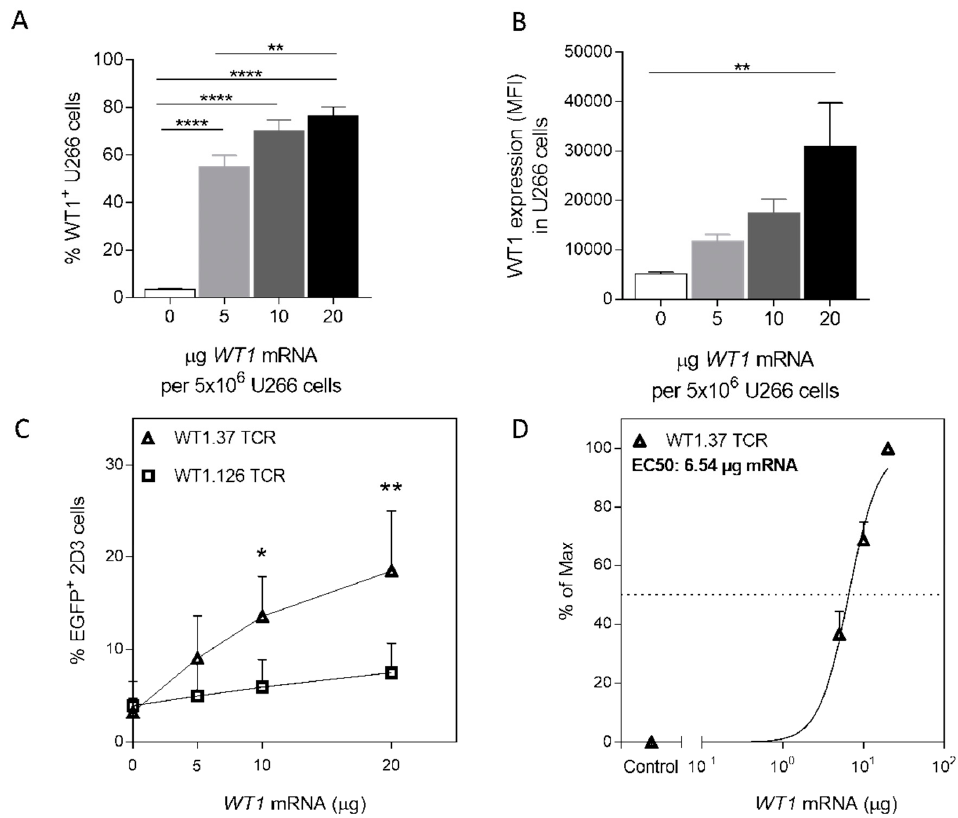
Figure 3. Epitope-specific TCR-engineered 2D3 cells can recognize full-length antigen WT1 mRNA- electroporated U266 cells in a dose-dependent manner. ( A , B ) Intracellular expression of WT1 is shown for U266 cells 24 h after electroporation with increasing amounts of WT1 mRNA per 5 × 10 6 U266 cells. ( C , D ) 2D3 cells were electroporated with WT1 37–45 - or WT1 126–134 -specific TCR mRNAs. Specific activation was detected by NFAT-promoted EGFP expression in 2D3 cells after 18–22 h co-culture with U266 cells electroporated with increasing amounts of WT1 mRNA. Graphs show the mean percentage of WT1 + U266 cells ± SEM ( A ), the median fluorescence intensity (MFI) of U266 for WT1 expression ± SEM ( B ), the percentage of maximal EGFP expression ± SEM ( C ) and EC50, the amount of WT1 mRNA at which 50% of the maximal EGFP expression is reached ( D ) of 3–4 independent replicates. ( A , B ) One-way ANOVA followed by Tukey’s post hoc test. ( C ) One-way ANOVA followed by Dunnett’s post hoc test (comparing to mock-electroporated cells). *, p < 0.05; **, p < 0.01; and ****, p <